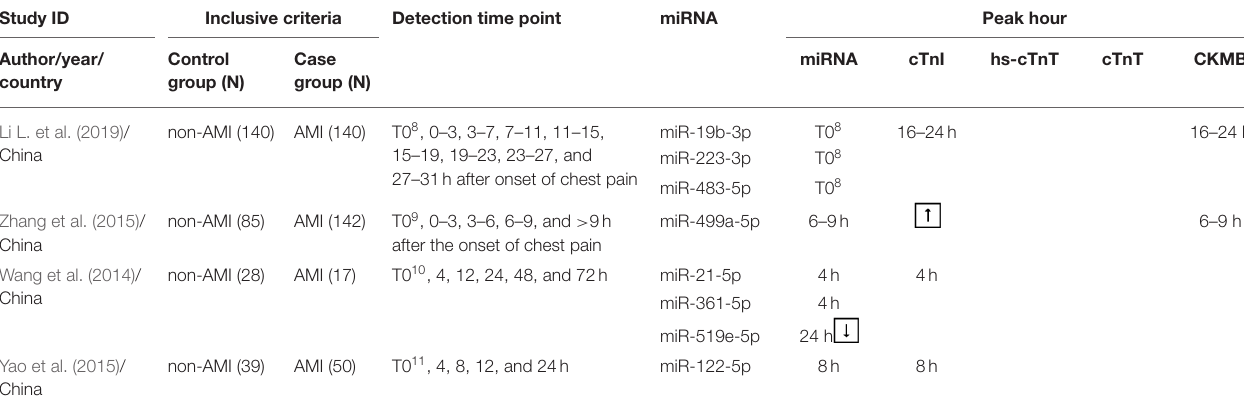
TABLE 3A | Peak hour and AUC comparison of miRNAs and conventional biomarkers. Study ID